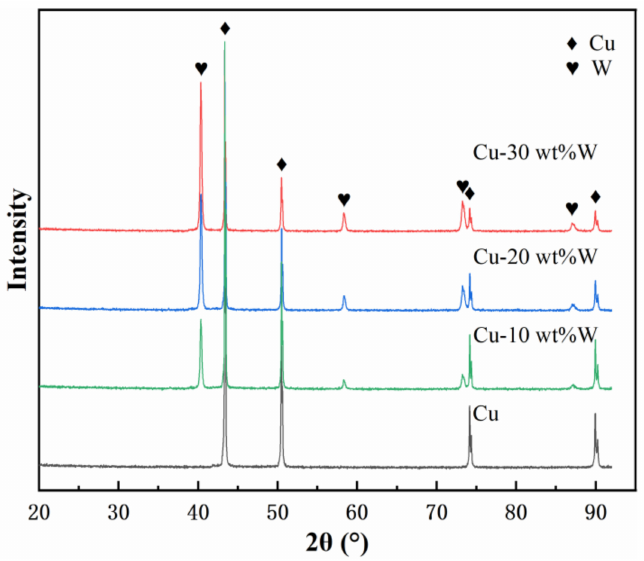
Figure 13. XRD patterns of reduced powders with various W contents. SEM and BSE images of Cu-10 wt%W, Cu-20 wt%W, and Cu-30 wt%W